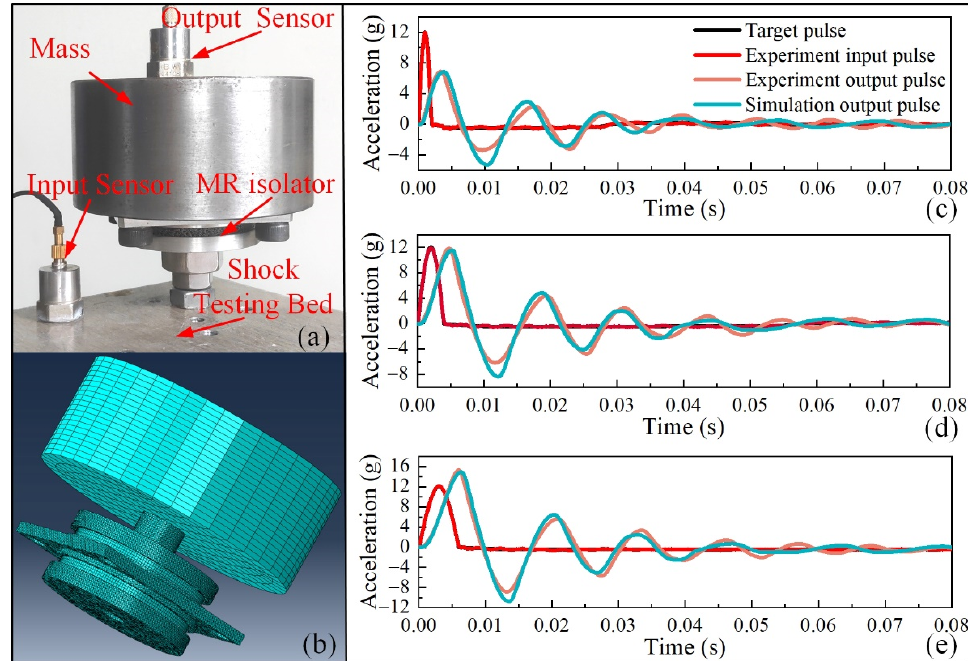
Figure 13. Shock experiment and FEM simulation: ( a ) shock testing system, ( b ) FEM model, ( c ) results of periods of 2 ms, ( d ) results of periods of 4 ms, ( e ) results of periods of 6 ms.